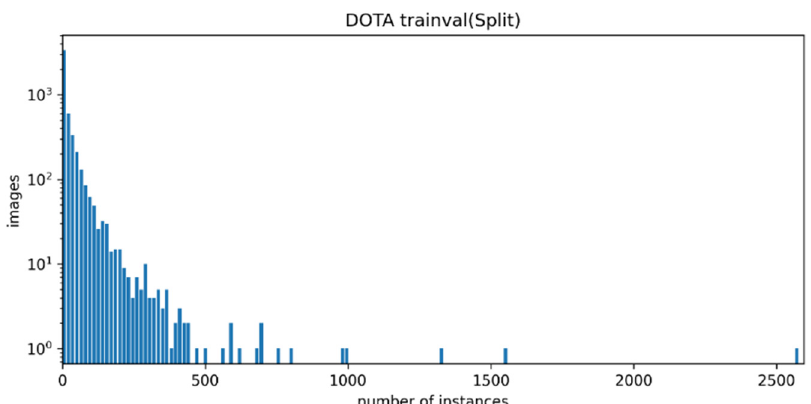
Figure 7. Object number in the DOTA-v1.5 dataset.